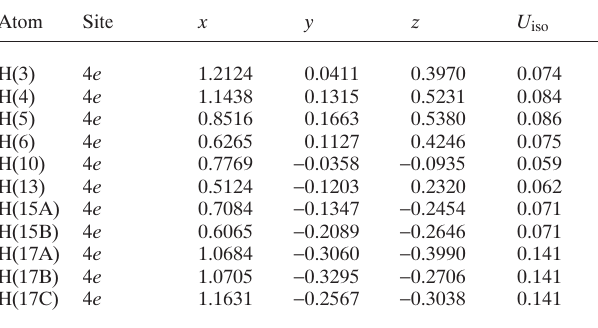
Table 2. Atomic coordinates and displacement parameters (in Å 2 )